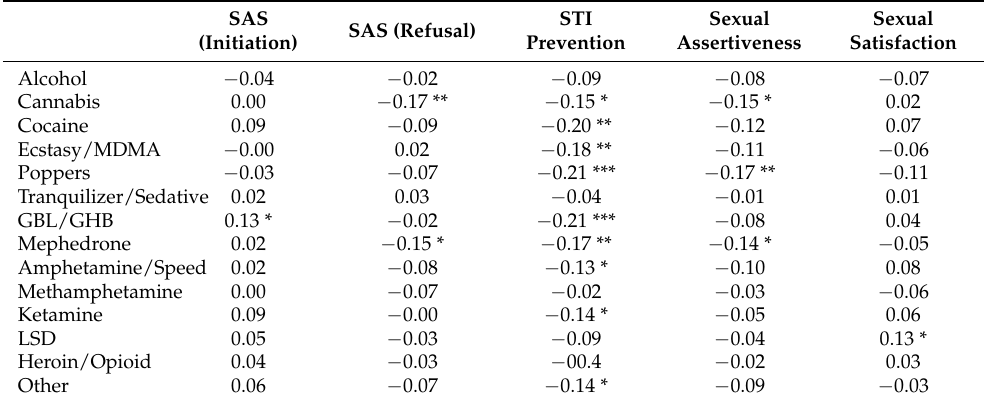
Table 4. Bivariate correlations of sexual assertiveness and sexual satisfaction with the frequency of substance